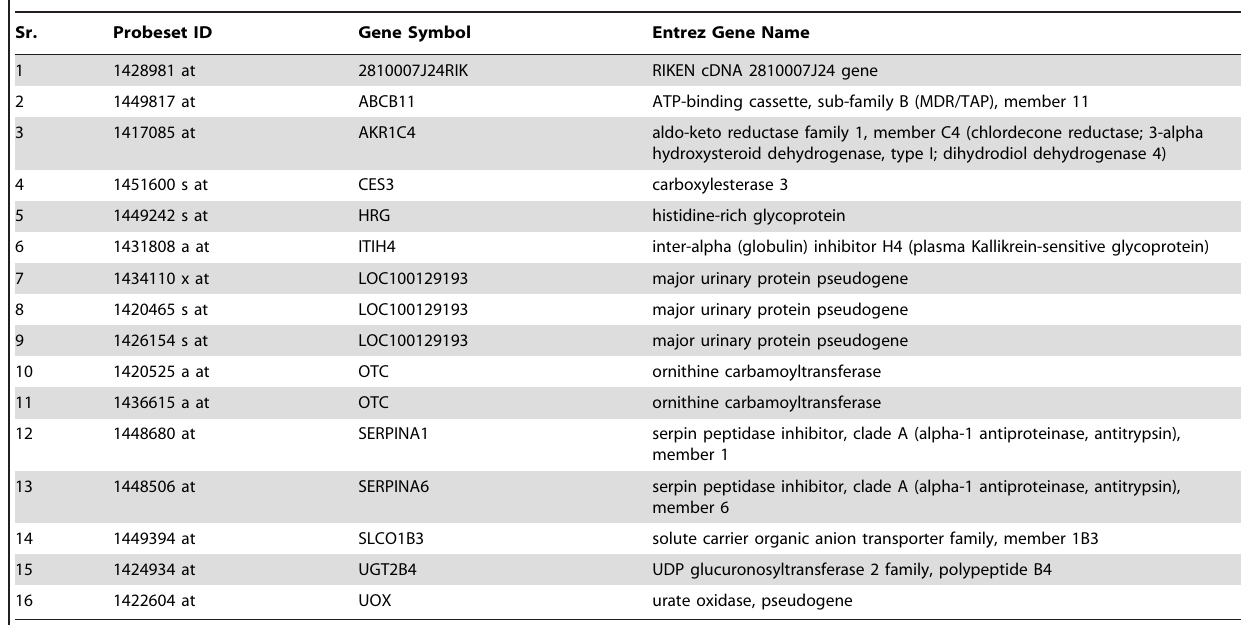
Table 16. Liver 1 liver 4 cluster 3.